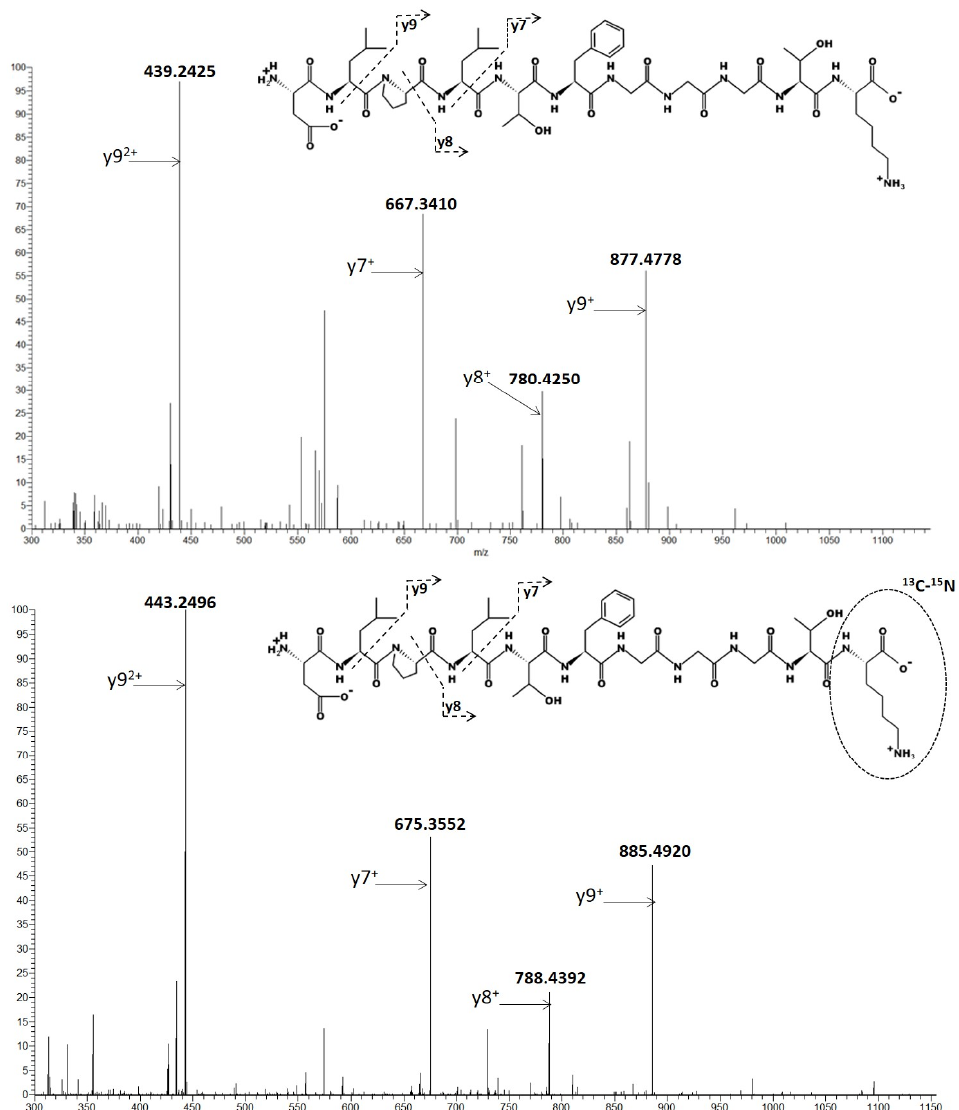
Figure 4. MSD2 spectra of PBZ (up) and SIL-PBZ-like (down) of a G1 sample (1 µ g/mL and 10 µ g/mL respectively). Peptide sequence of DLPLTFGGGTK (LC8) and daughter ions are represented on the bottom right of each figure. The +2 forms of LC8 were selected as precursor ions with m/z = 553.2980 and 557.3051 for PBZ and SIL-PBZ-like, respectively. Analysis of 10 double blank plasma samples (no PBZ or SIL-PBZ-like added) did not show any interference (Figure 5). Likewise, no signal was observed from samples spiked with nivolumab, ipilimumab, rituximab, or cetuximab.